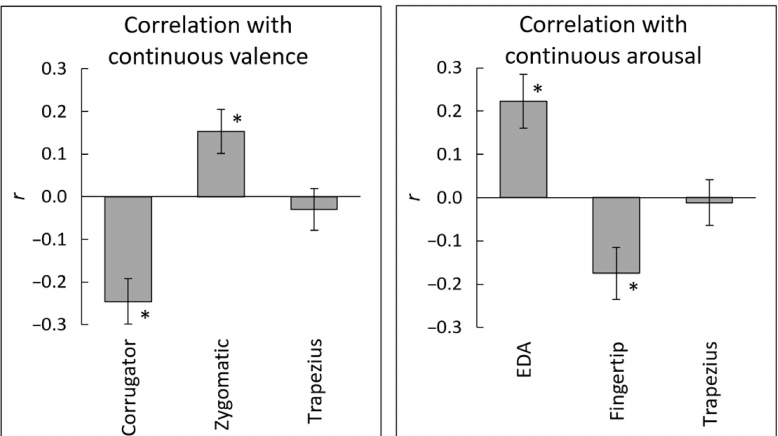
Figure 4. Mean ( ± standard error) intra-individual correlation coefficients of expected subjective– physiological concordance over time. Associations were expected between the valence ratings and electromyography (EMG) activity of the corrugator supercilii, zygomatic major, and trapezius muscles, and between the arousal ratings and electrodermal activity (EDA), fingertip temperature, and trapezius EMG. * , p <